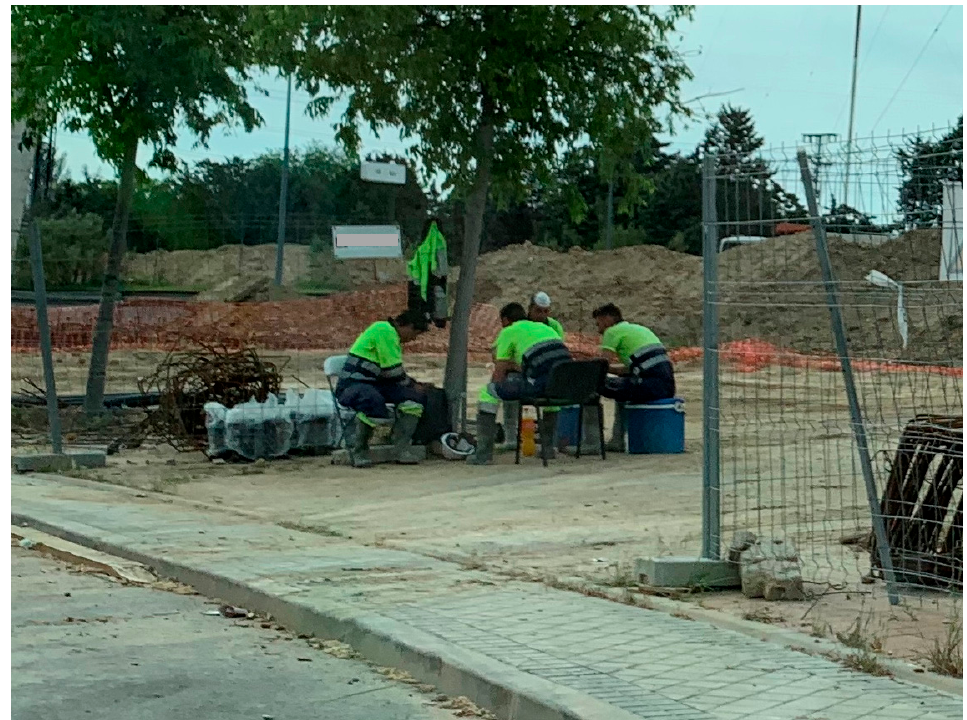
Figure 5. Workers having lunch outside the dining booth and not keeping a safe distance (author’s photograph).